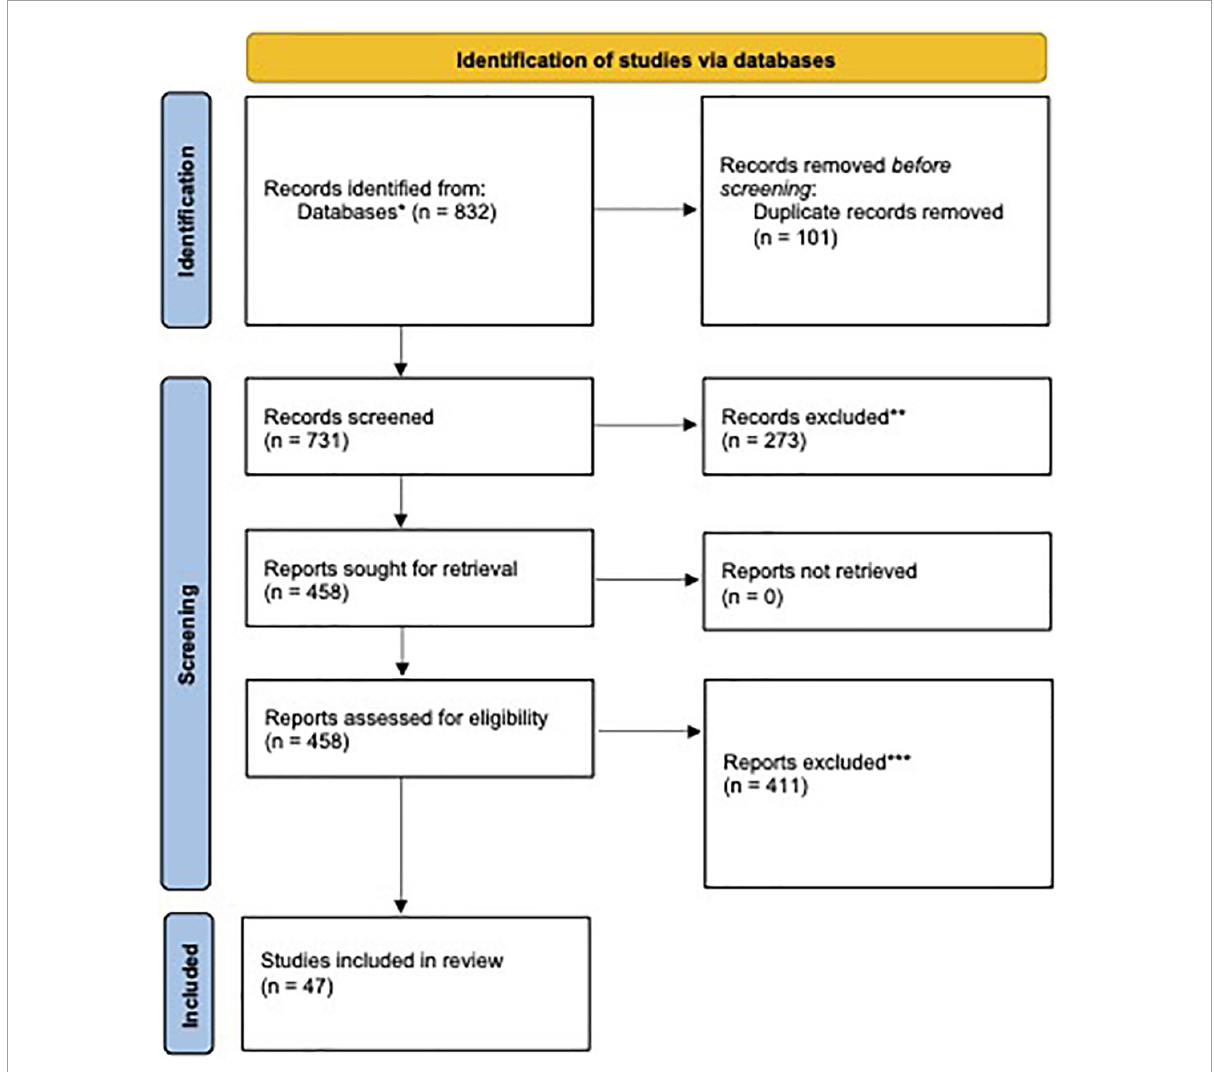
FIGURE1 PRISMA 2020 flow diagram for new systematic reviews which included searches of databases and registers only. *Breakdown by source: PubMed ( n = 220), EMBASE ( n = 354), PsycINFO ( n = 13), MEDLINE complete ( n = 206), and global health ( n = 39). **Exclusion was done manually by researchers. No automation tools were used. Reasons included (1) did not involve medical students, (2) did not study the impact of COVID-19, (3) not accessible in English, and (4) publications that were not full-text (i.e., conference abstracts). ***Reasons for exclusion included (1) did not involve measurements of anxiety, depression, or stress, (2) medical students were grouped with non-medical students, and (3) self-reported anxiety, depression, or